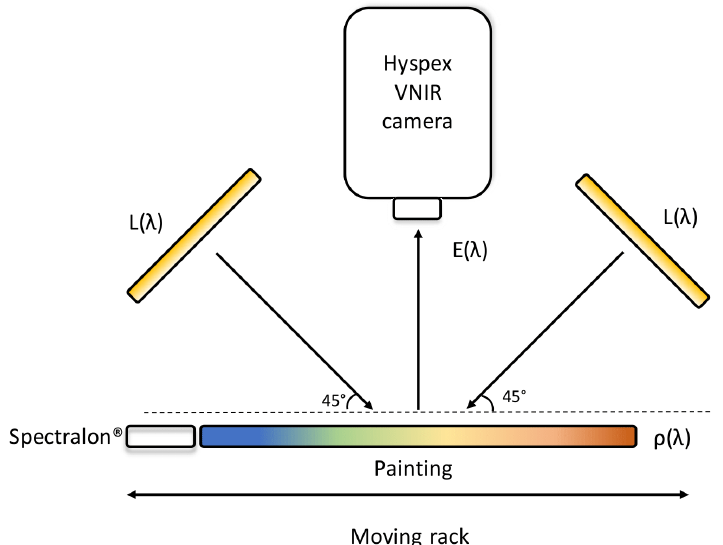
Figure 4. Hyperspectral image acquisition setup. The light sources are placed at 45°, while the camera is at 0°. This allows avoiding specular reflection and shadows. In the push broom setup, the translator stage slides across the field of view of the camera at a speed synchronised with the integration time of the